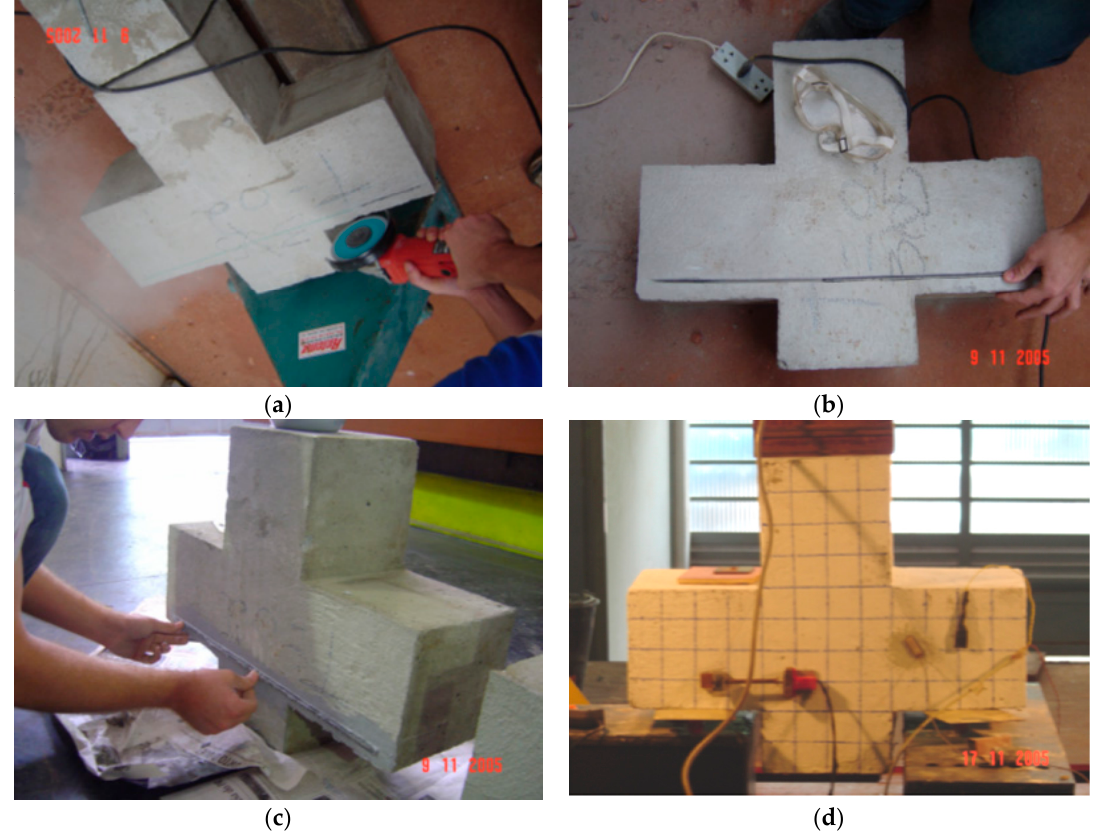
Figure 2. Corbel strengthened using carbon fiber reinforced polymers (CFRP) laminate strips using the near surface mounted method: ( a ) cut of the lateral faces; ( b ) lateral cut finished; ( c ) laminate strips glued with resin epoxy in the slits; and ( d ) reinforced concrete corbel strengthened with CFRP laminate strips being tested. (Source: Souza et al. [4]).